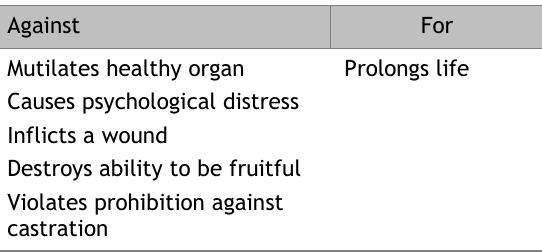
Table 1. Halachic Debate over Prophylactic